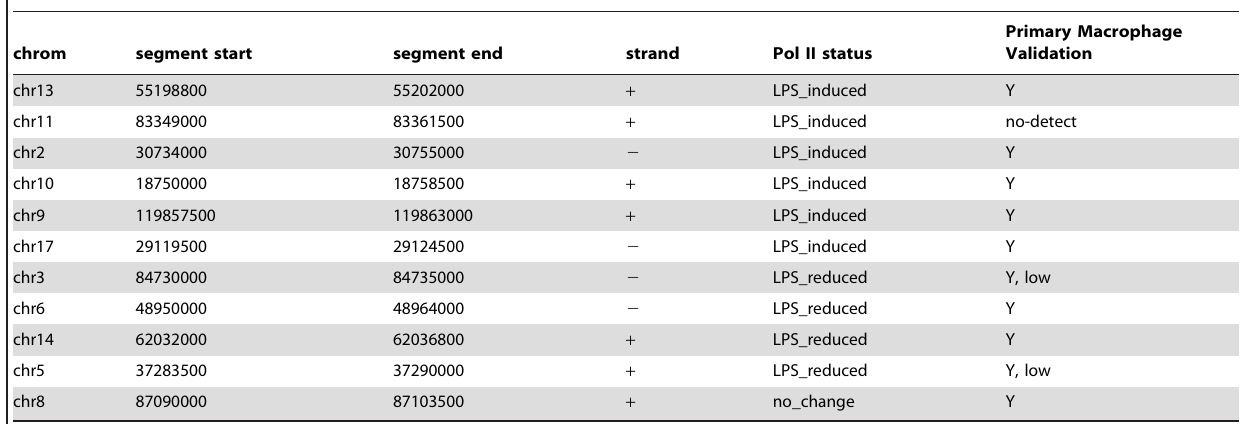
Table 1. Experimental validation on 11 regions of lincRNAs.